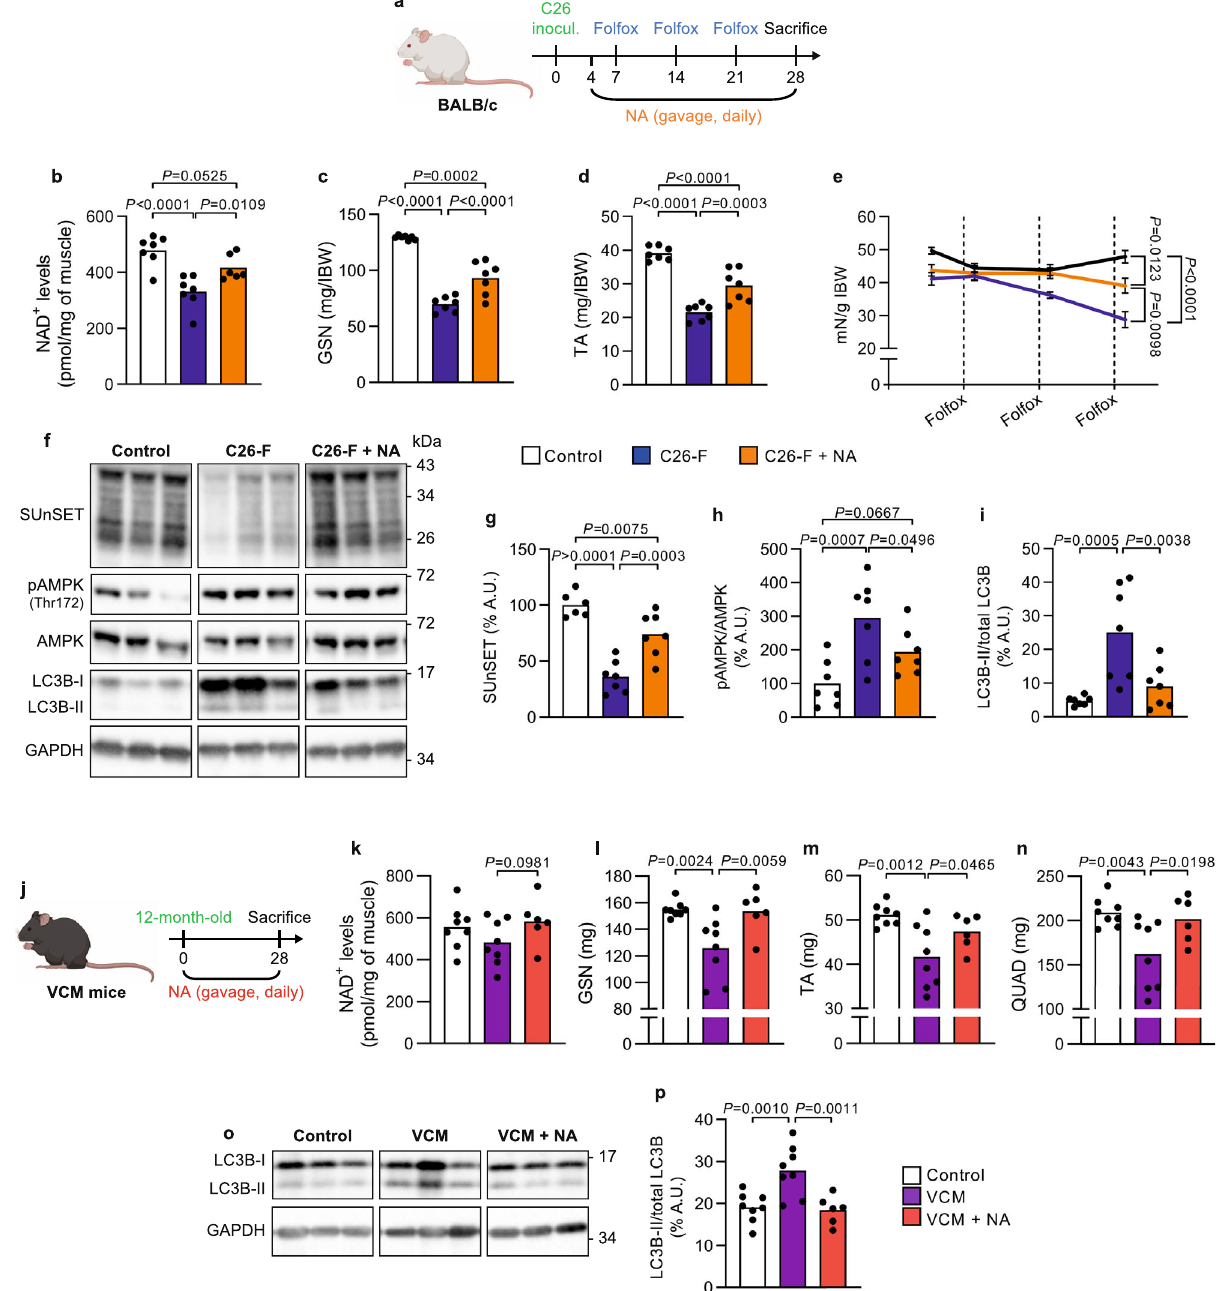
Fig. 3 | Effects of NA treatment on muscle mass, muscle function and protein metabolism in CC mouse models. a Study design of the C26-F model and NA treatmentwiththreeexperimentalgroups:control,C26-Fand C26-F+NA. b Levels of NAD + represented as pmol per mg of muscle (control n =7, C26-F n =7, C26- F+NA n =6). c , d Gastrocnemius (GSN)and tibialisanterior (TA)musclewetweight normalizedtoinitialbodyweight(IBW)( n =7pergroup). e Graspingstrengthatthe start of NA treatment and the day after every Folfox administration ( n =7 per group). f – i Representative western blotting bands ( f ) and densitometry analysis of puromycin incorporation (SUnSET analysis) ( g ; control n =6, C26-F n =7, C26- F+NA n =7),LC3B-IInormalizedtototalLC3B( h ; n =7pergroup)andp-AMPK Thr172